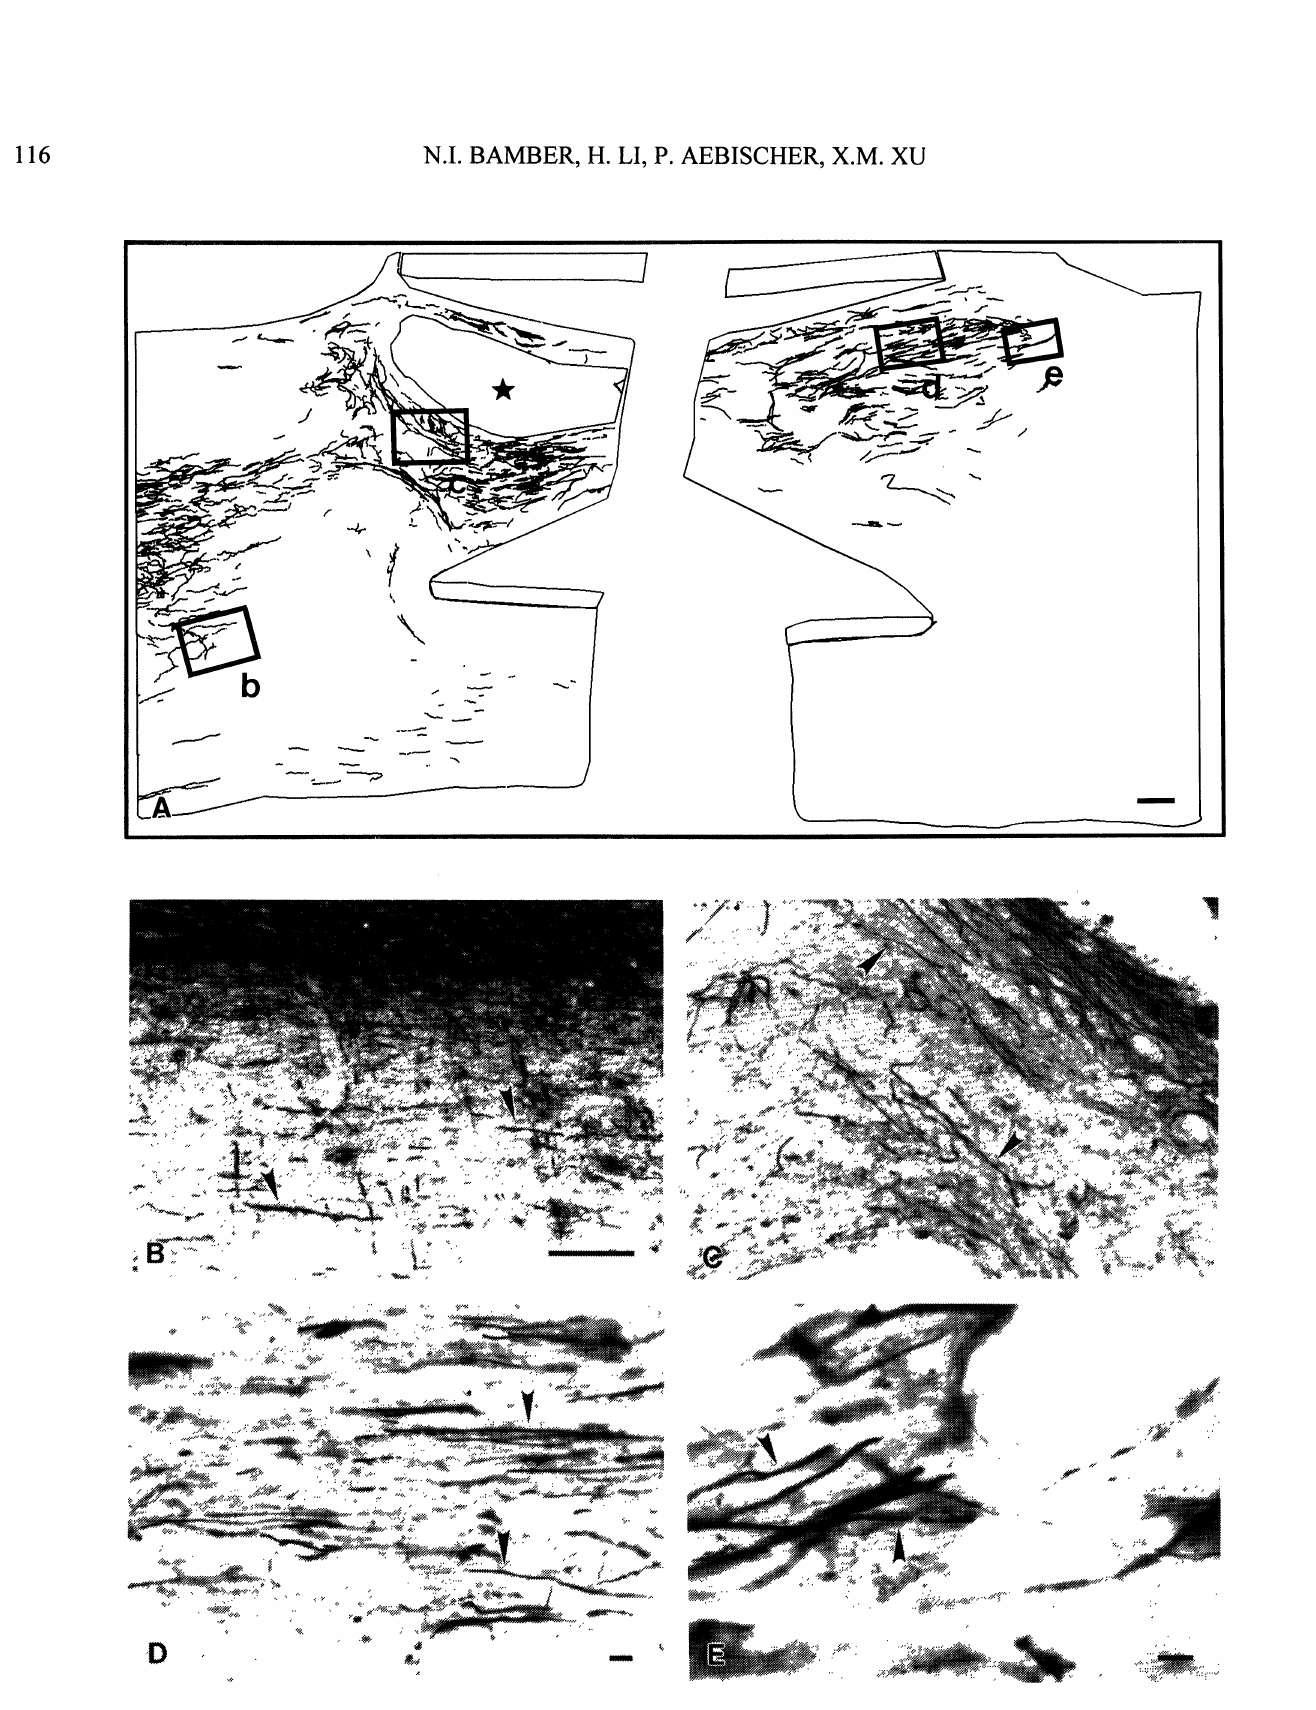
: A: Neurolucida reconstruction of a horizontal section of the graft and the host at the transplant site showing that axons Fig. anterogradely labeled with PHA-L grew into the FSC graft. Representative areas of interest are labeled (b-e) in A and are presented photographically at high magnification in B-E. Axons were identified in the rostral spinal cord (B), entering the FSC graft (C), at the distal portion of the FSC graft (D) and penetrating the distal host-graft interface for only a short distance (E). A cavity at the rostral end of the FSC graft is indicated (’A-). Bars: A-C 1001am; D-E